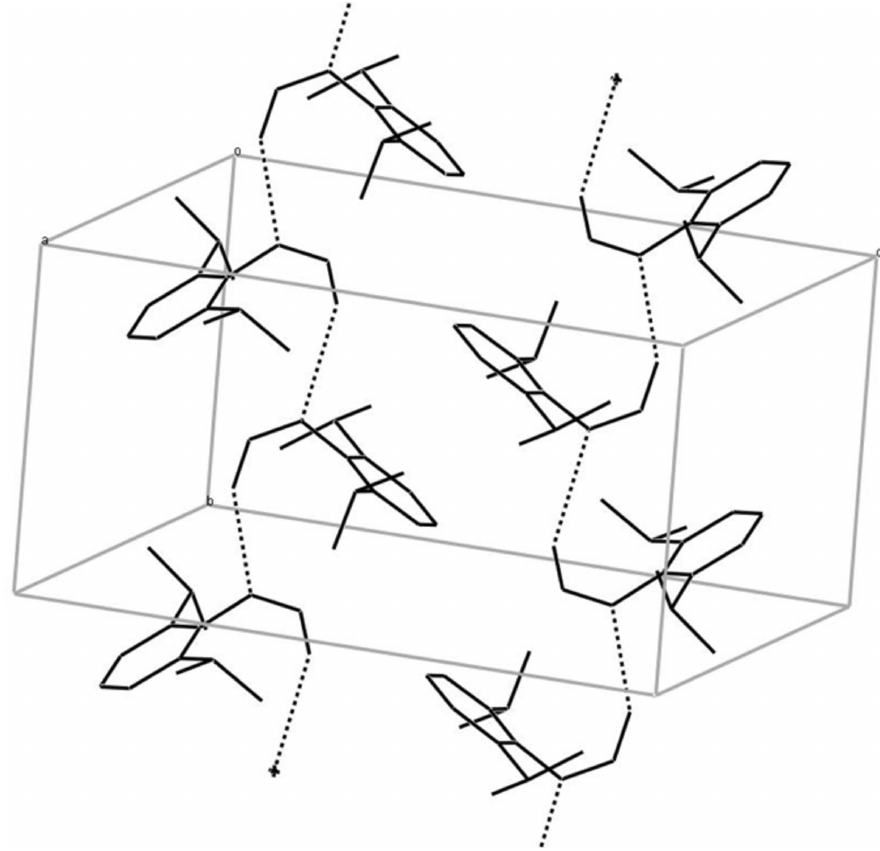
Figure 2 The packing of (I), with hydrogen bonds shown as dashed lines. For clarity, H-atoms have been